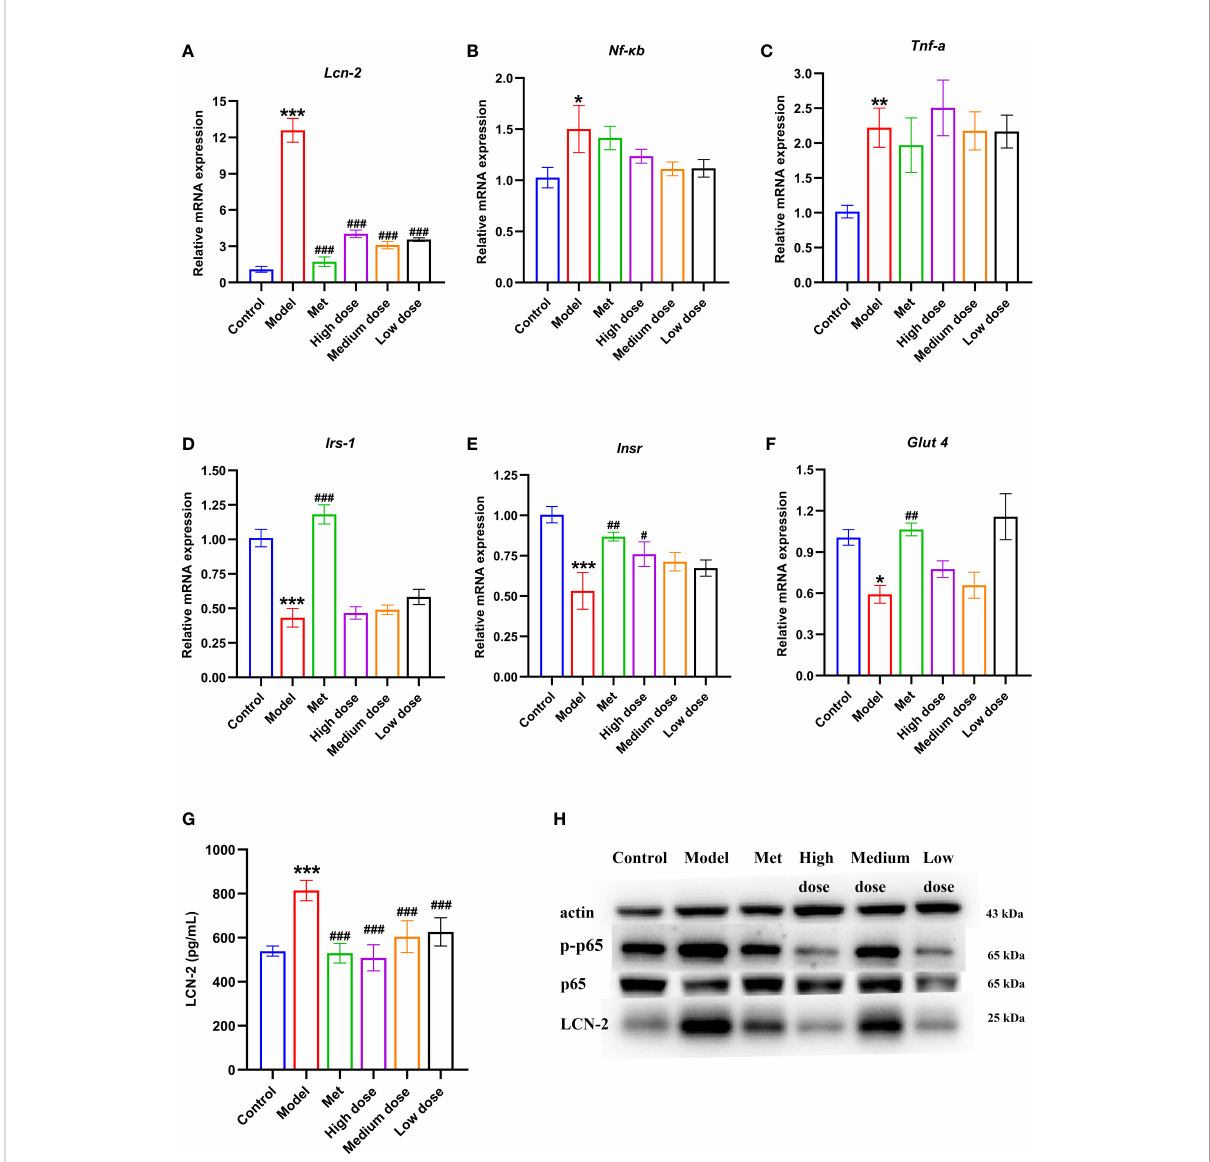
FIGURE 8 Effects of MCDD on serum LCN-2 content, genes of insulin signal transduction pathway, in fl ammatory factors of NF- k B in fl ammatory pathway, LCN-2 and NF-kB p-p65 protein in ovarian tissue. qRT-PCR detection of gene expression of IRS-1 , INSR and GLUT 4 in rat ovarian